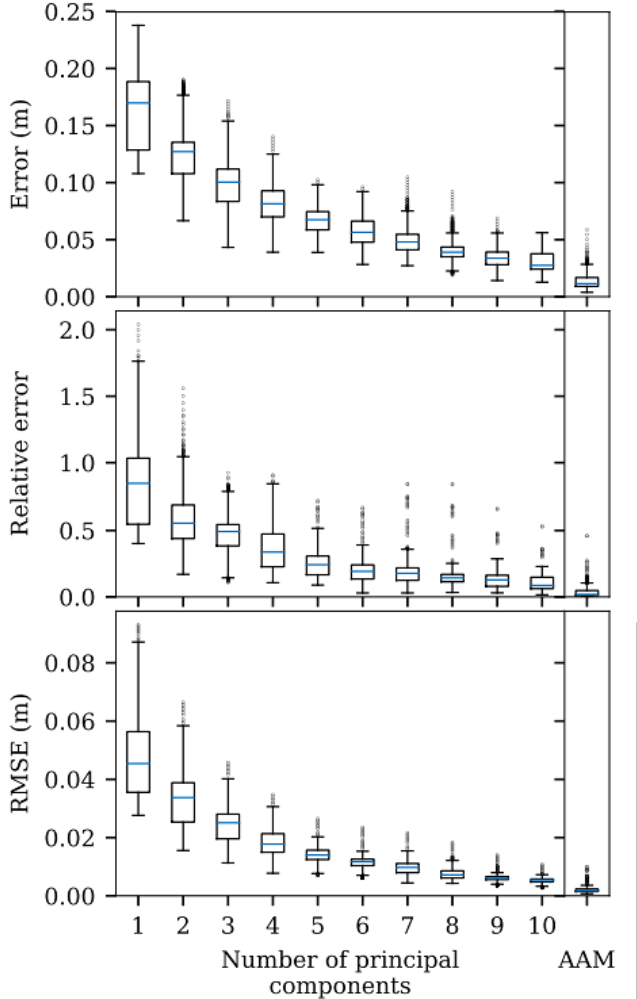
Figure 3. Distributions of time maximum absolute error, relative error and RMSE between test trajectories and reconstructions with increasing number of principal components (left), and reconstructions by a one dimensional AAM (right) when only the coefficient of restitution varies. Blue lines indicate the medians. Boxes span the interval between first and third quartiles. Whiskers reach the last data point above (resp. below). Dots are points outside the reach of the